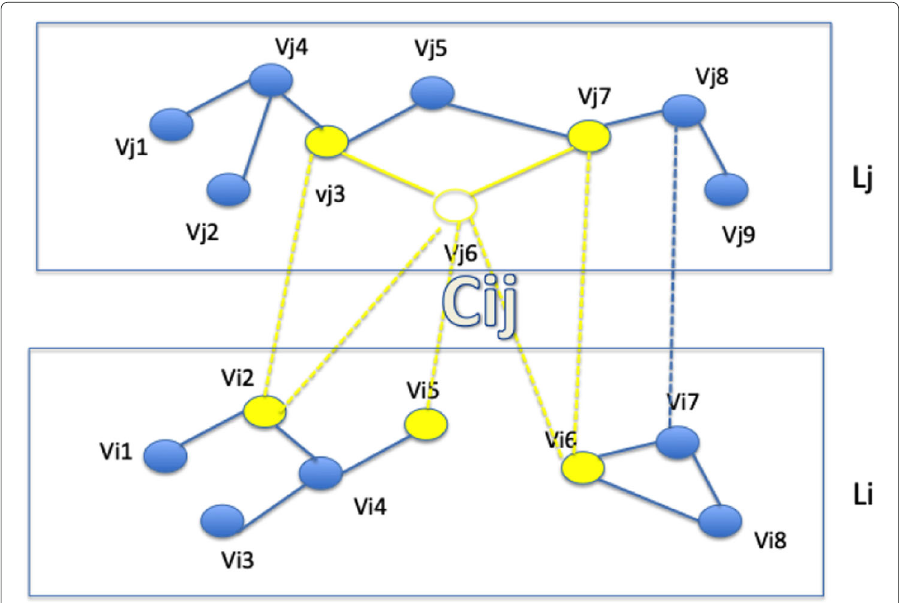
Fig. 3 Example of a 2-layers egocentric